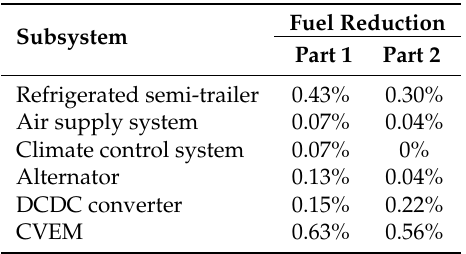
Table 1. Fuel reduction results on the high-fidelity vehicle model. CVEM, complete vehicle energy